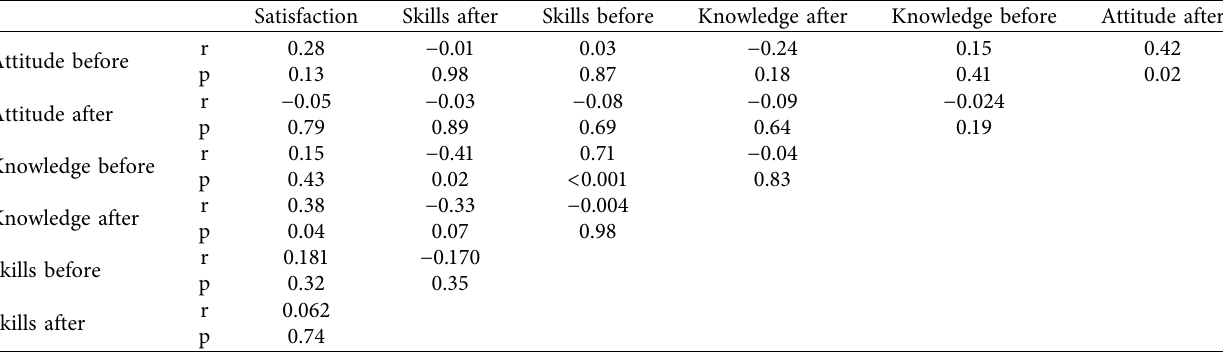
Table 3: Correlations between the scores of midwives’ PPH knowledge and problem-solving skills and attitude before and after electronic CME learning. Satisfaction Skills after Skills before Knowledge